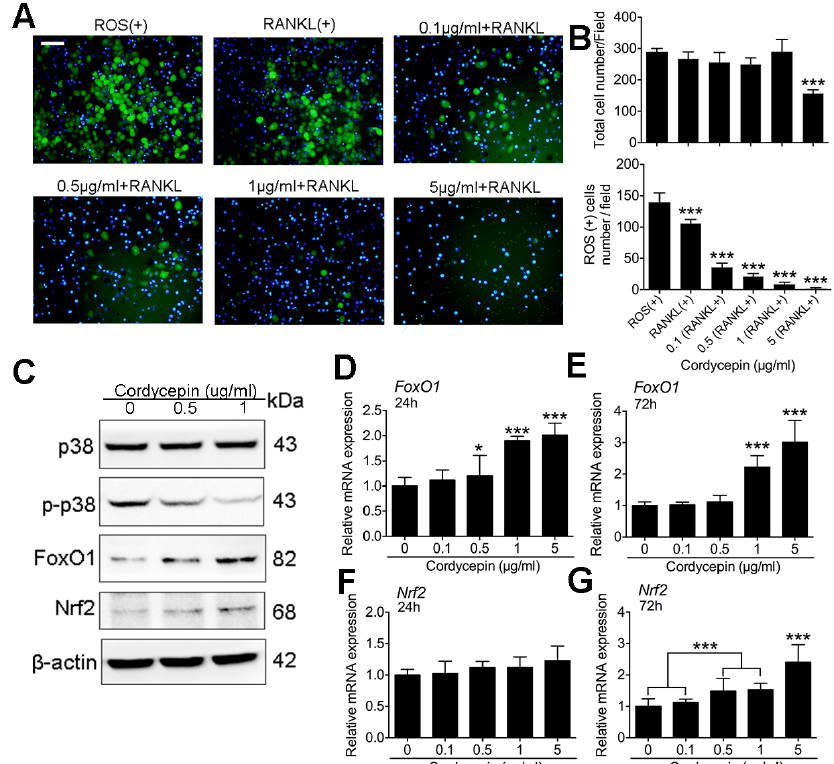
Figure 5. Cordycepin scavenges ROS generation and activates FoxO1 and Nrf2 expression. ( A ) Representative images of ROS positive BMMs during RANKL induced osteoclastogenesis treated with different concentrations of cordycepin (0 μ g/mL, 0.1 μ g/mL, 0.5 μ g/mL, 1 μ g/mL, and 5 μ g/mL). ( B ) Quantification of total cell number and ROS positive cell number in each field. ( C ) Representative Western blot images of p38, p ‐ p38, FoxO1, Nrf2 and β‐ actin. For blotting of p38 and p ‐ p38, cells were pretreated with different dosages of cordycepin for 24 h and then induced with RANKL and M ‐ CSF for 15 min. For FoxO1 and Nrf2, cells were treated with different dosages of cordycepin for 72 h with RANKL and M ‐ CSF. ( D , E ) Relative mRNA expression levels of FoxO1 at 24 h ( D ) and 72 h ( E ) during osteoclastogenesis. ( F , G ) Relative mRNA expression levels of Nrf2 at 24 h ( F ) and 72 h ( G ) during osteoclastogenesis. Scale bar represents 200 μ m. Data in the figures represent average ± SD. * p < 0.05, *** p < 0.001 based on one way ANOVA.